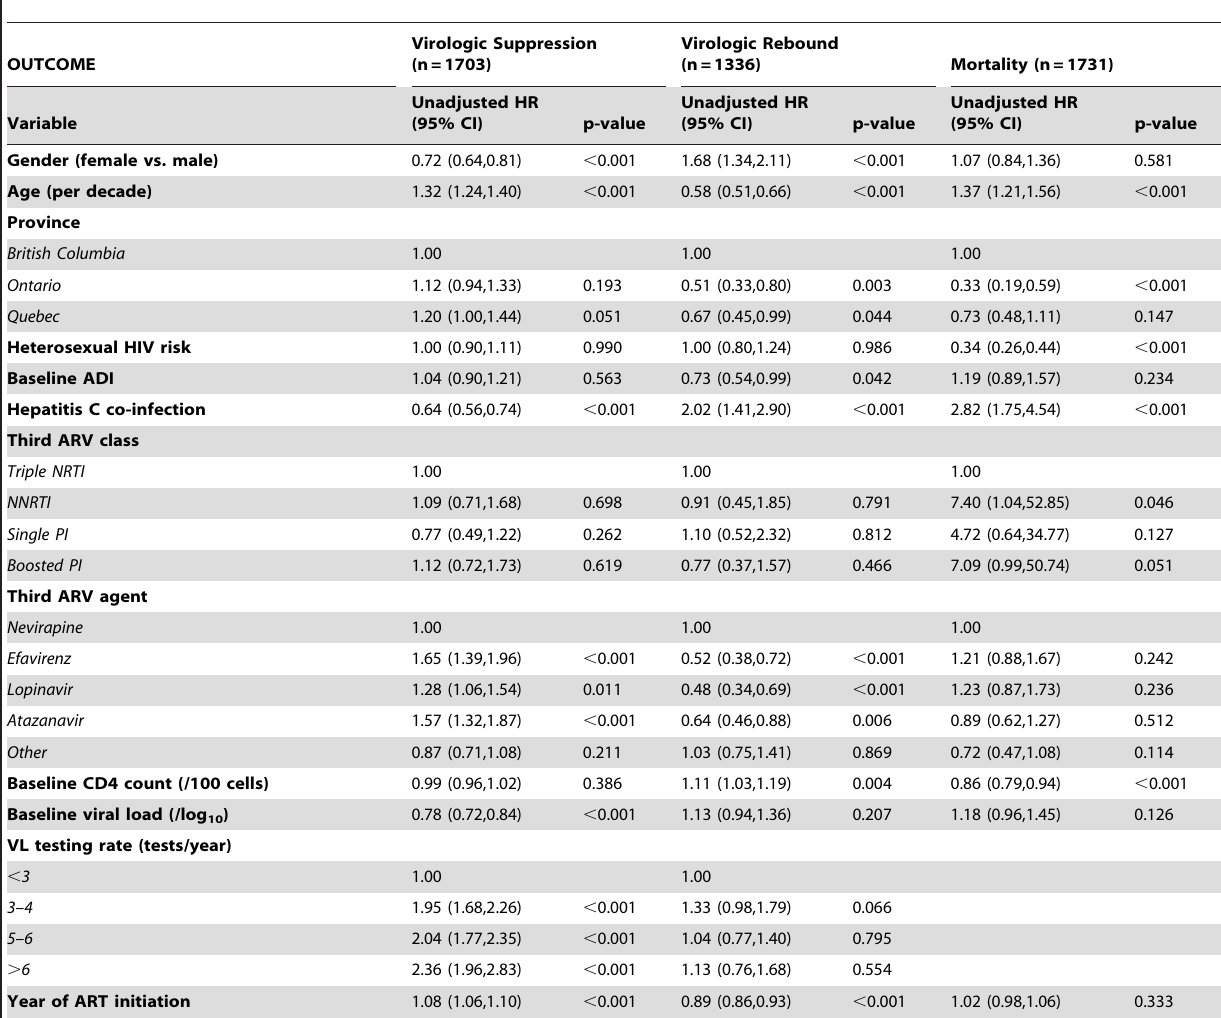
Table 2. Unadjusted analyses exploring gender differences in clinical outcomes among individuals with IDU